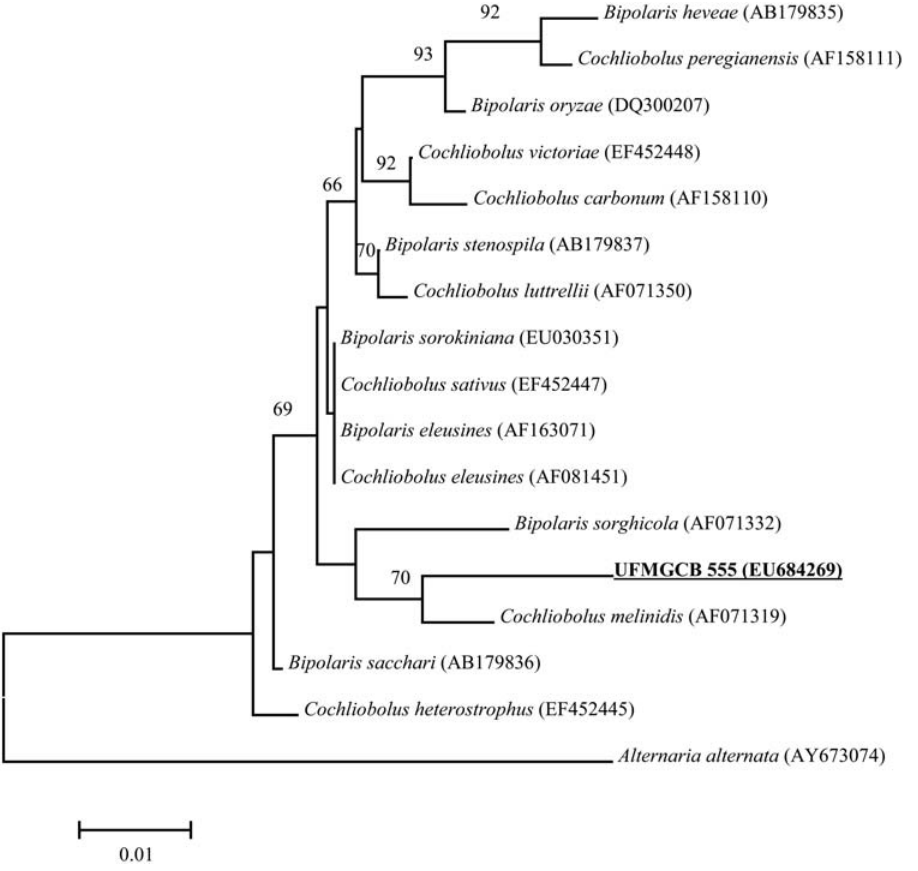
Figure 2. Flowchart illustrating the isolation of cochlioquinone A and isocochlioquinone A. The fractionation was guided by the bioassay with the enzyme trypanothione reductase, in which the crude extracts, fractions, and isolated compounds were tested at 20 m g mL 2 1 .